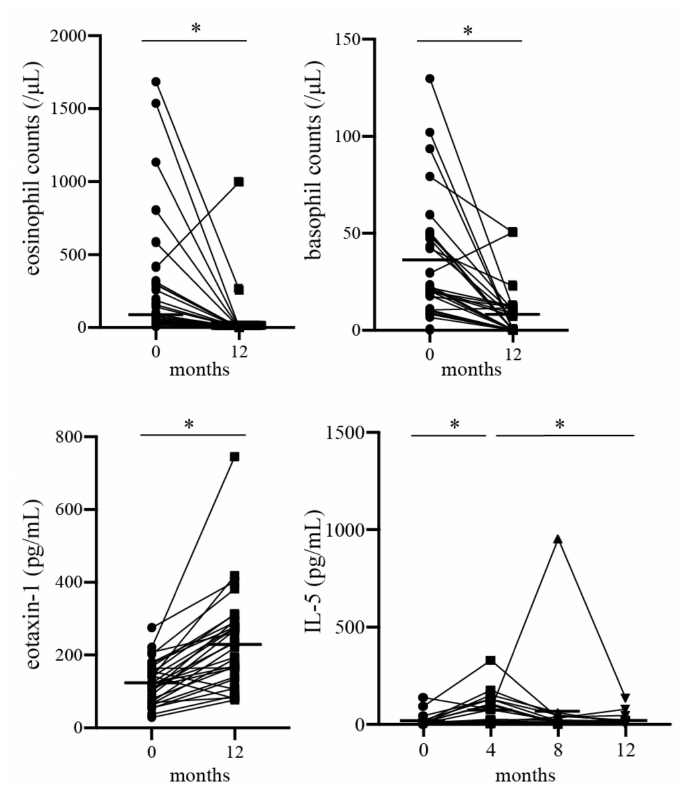
Figure 1. Changes in parameters from baseline to 12 months after treatment with benralizumab. Circulating eosinophil and basophil counts reduced significantly after benralizumab treatment. Serum eotaxin-1 levels and serum IL-5 levels increased significantly over the 1 year period and up to 4 months, respectively. Bars indicate median values. * p <